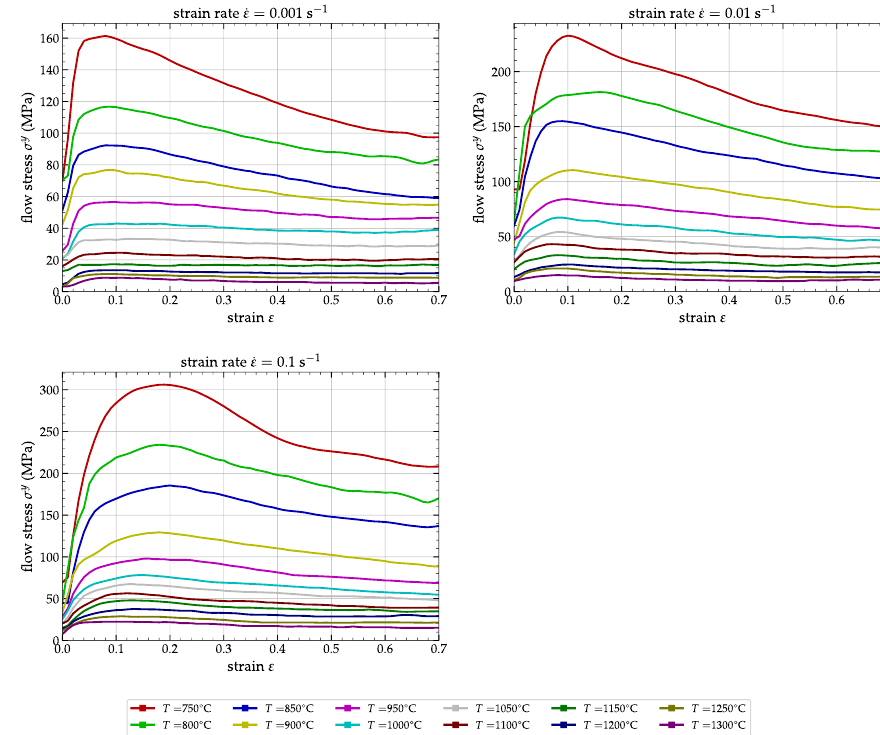
Figure 1. Original data extracted from the publication of Ji et al.